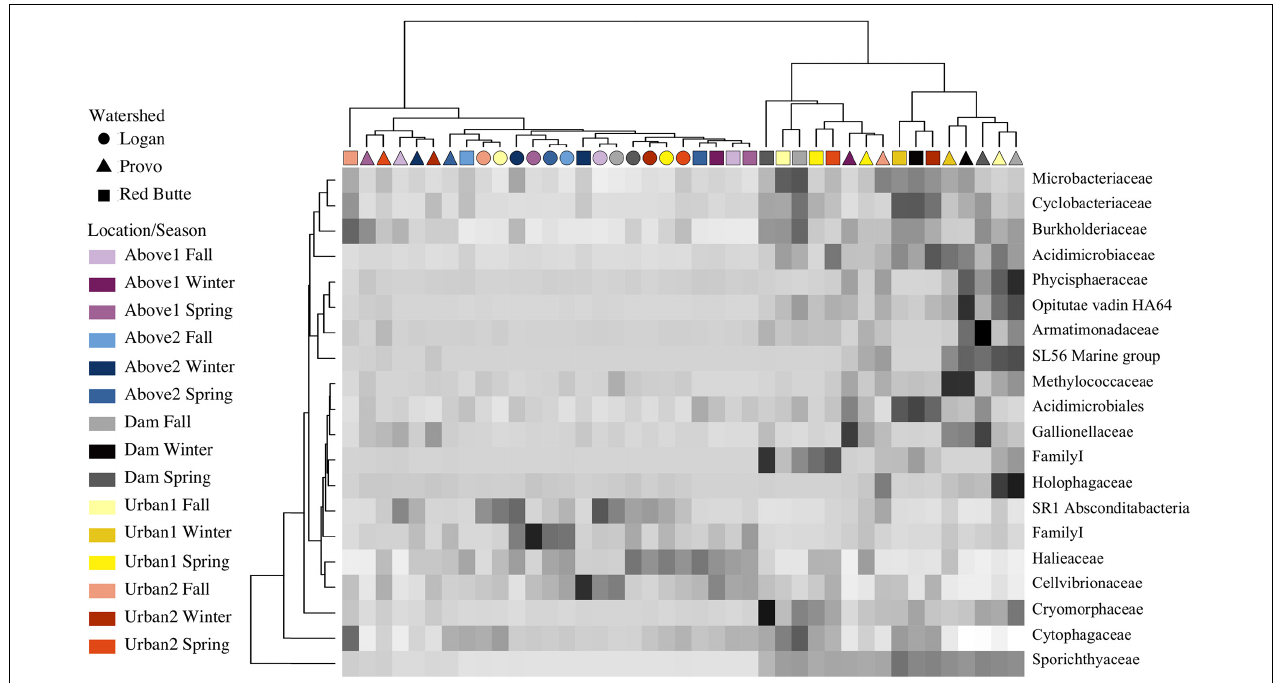
FIGURE 8 | Heatmap showing ANCOM results of differentially abundant family for sites in three watersheds across three seasons (Fall, Winter, and Spring). Taxa were selected using a family relative abundance at least 0.5% for all samples. Location indicates position within watershed relative to man-made reservoirs, with Dam sites located immediately downstream of reservoir outlets ( Table 1 ). Darker squares indicate higher relative abundance for bacterial families in each sample. Similarity between samples and taxa is indicated by dendrograms on each axis.